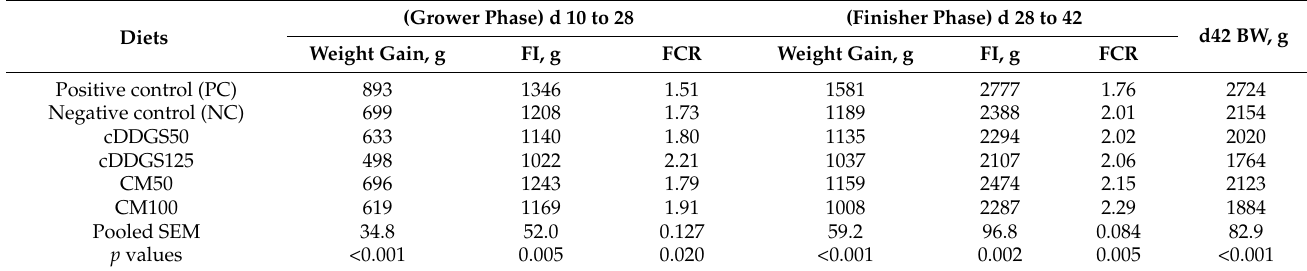
Table 7. Growth performance of broilers receiving diets containing soybean with reduction in crude protein or low-protein diets with serial inclusion levels of canola meal or corn–DDGS supplemented with crystalline amino